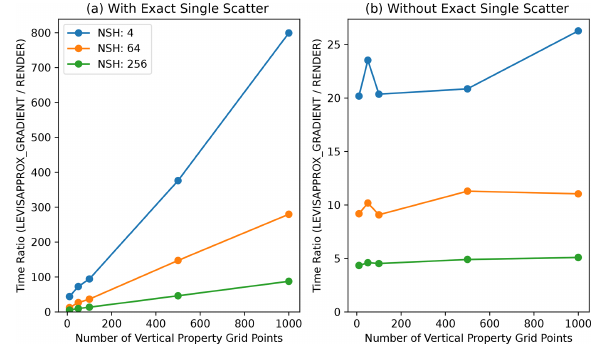
Figure G1. Relative timings of the approximate Jacobian and ra- diance calculation (LEVISAPPROX_GRADIENT) and the radi- ance calculation only (RENDER) as a function of the number of grid points for different numbers of spherical harmonics (NSHs). Panel (a) shows the relative timing of the default approximate Jaco- bian calculation, which includes a term ensuring exact single-scatter derivatives. Panel (b) shows the relative timing without that term. See the text for